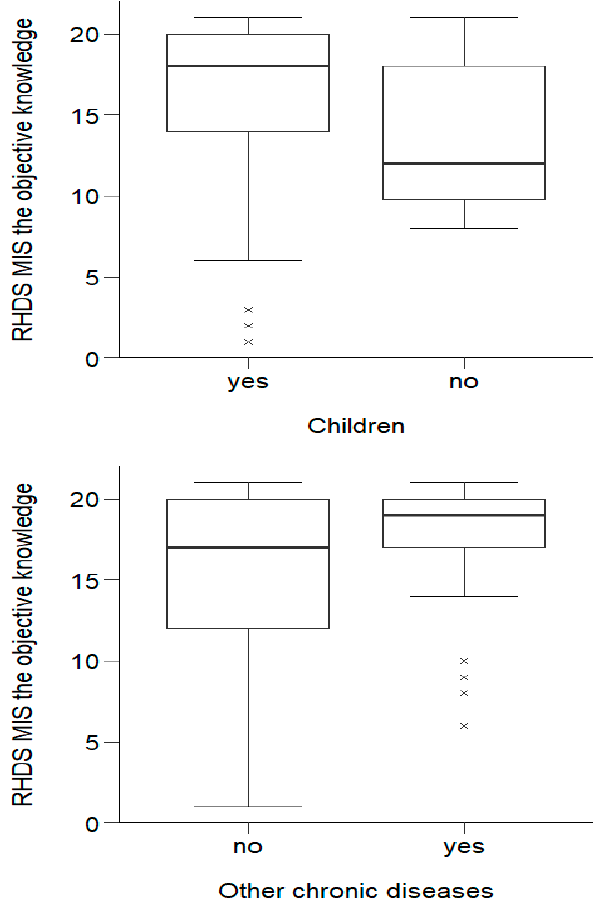
Figure 1. Effects of socio-demographic and clinical variables on objective knowledge about the disease in MI patients.